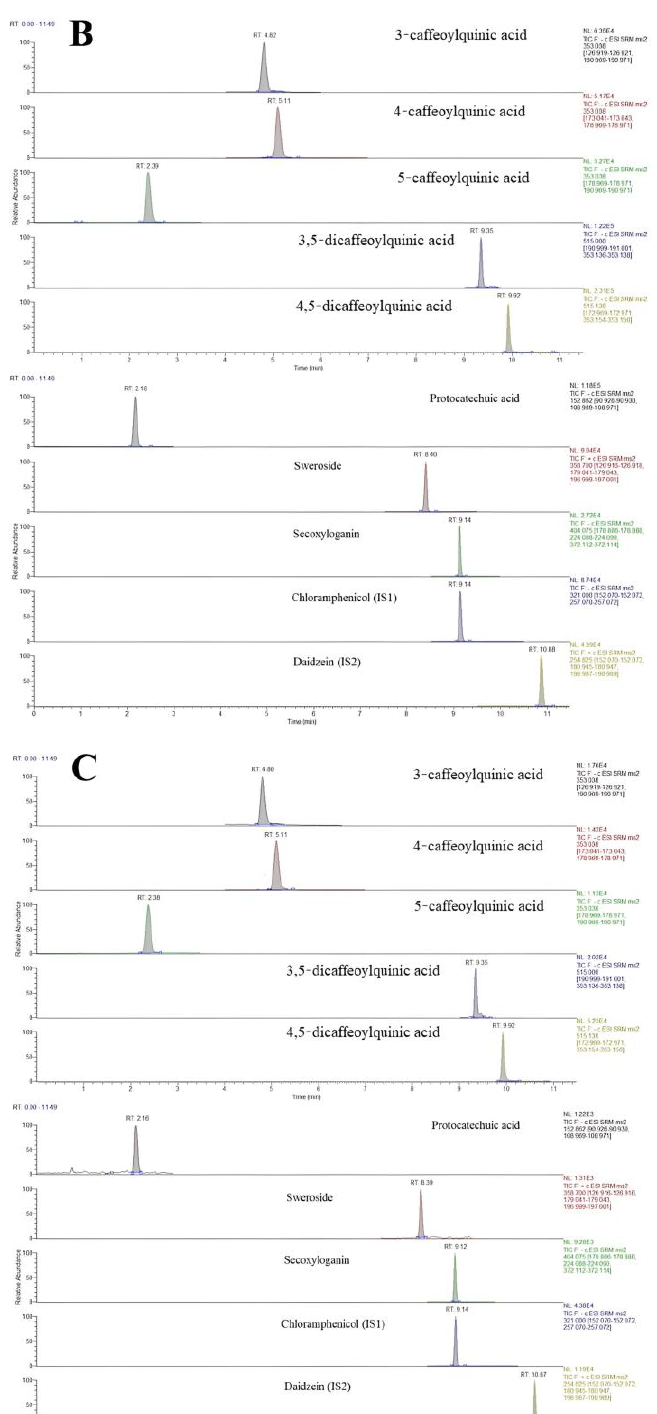
Figure 3. Typical MRM chromatograms of eight analytes and the ISs: ( A ) blank plasma, ( B ) blank plasma spiked with the analytes and IS, and ( C ) plasma samples 5 min after oral administration of the LJF aqueous extract.